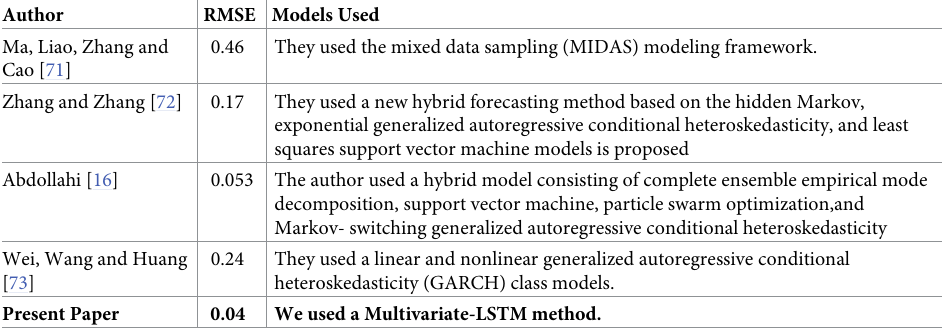
Table 8. A comparison wrt. RMSE of four different models with our model. Author